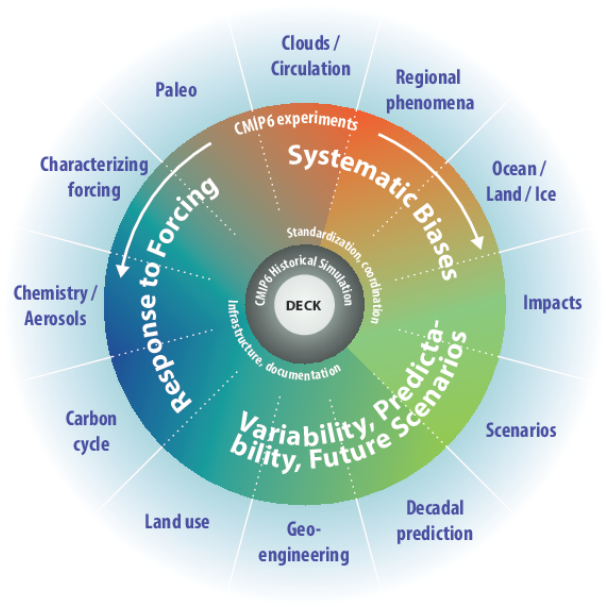
Figure 2. Schematic of the CMIP/CMIP6 experiment design. The inner ring and surrounding white text involve standardized func- tions of all CMIP DECK experiments and the CMIP6 historical simulation. The middle ring shows science topics related specifi- cally to CMIP6 that are addressed by the CMIP6-Endorsed MIPs, with MIP topics shown in the outer ring. This framework is super- imposed on the scientific backdrop for CMIP6 which are the seven WCRP Grand Science